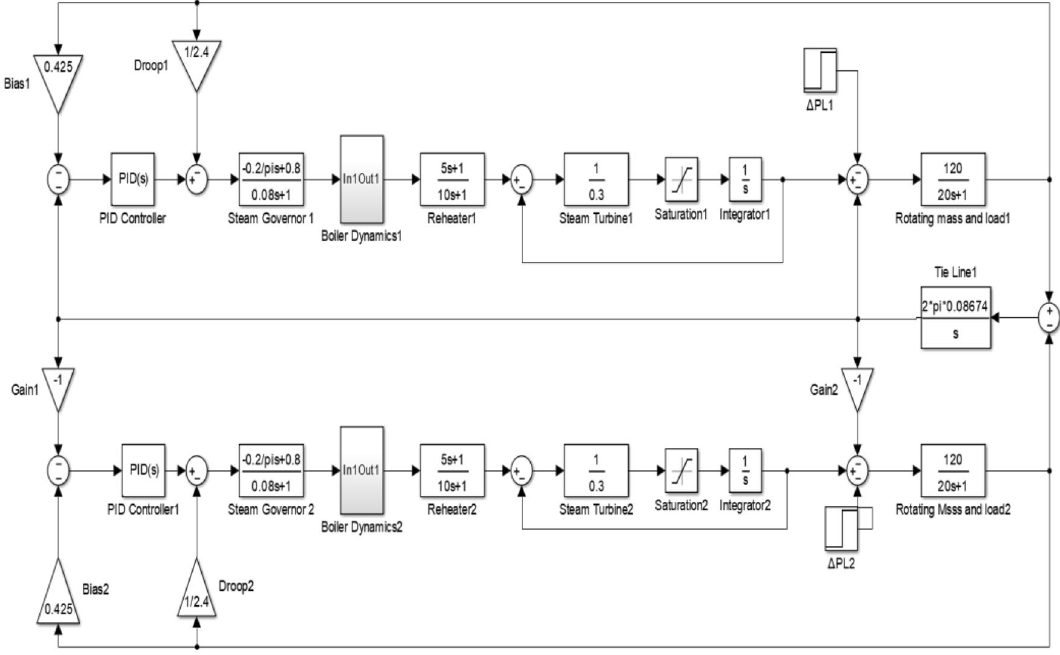
Fig. 3 Non-linear two-area